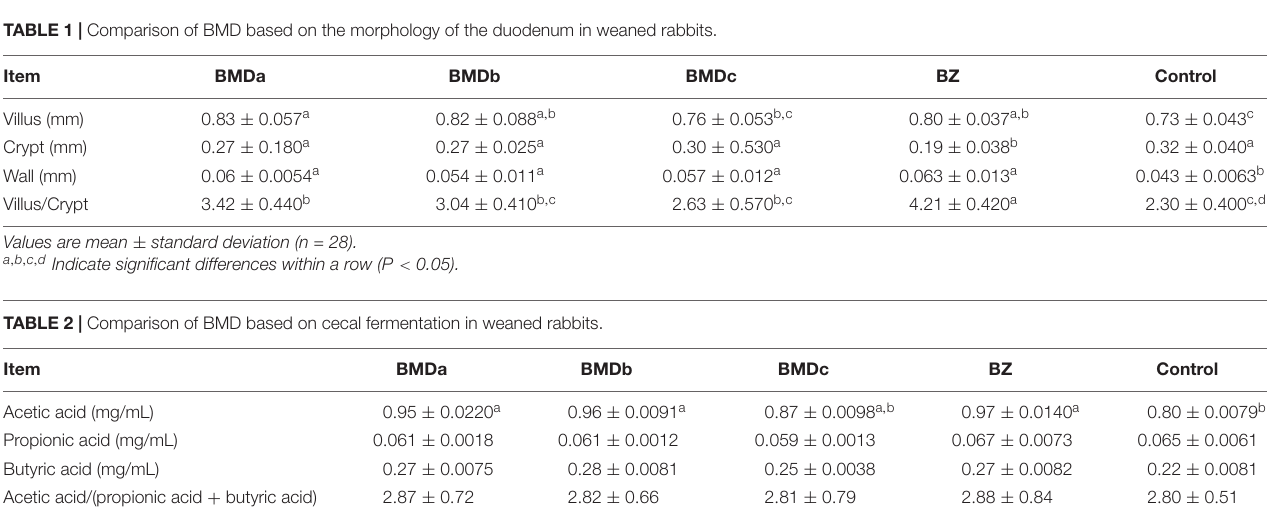
were identified across all samples at the class level ( Figure 3 ).